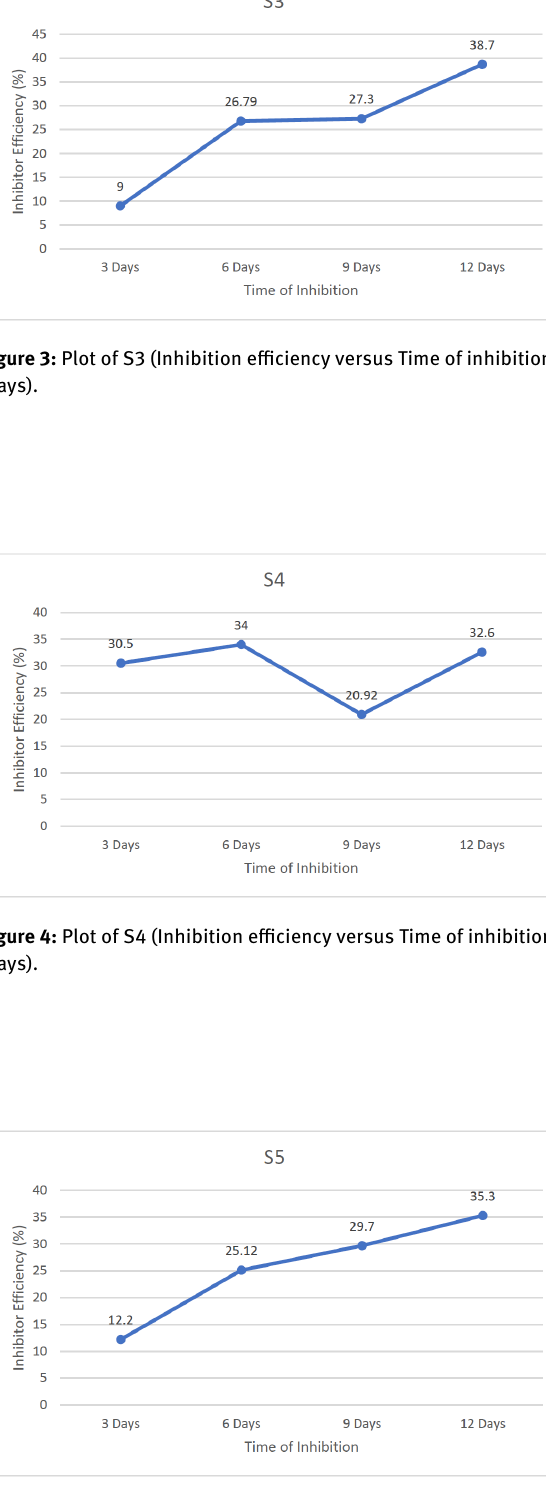
Table 4b: Weight loss α w.